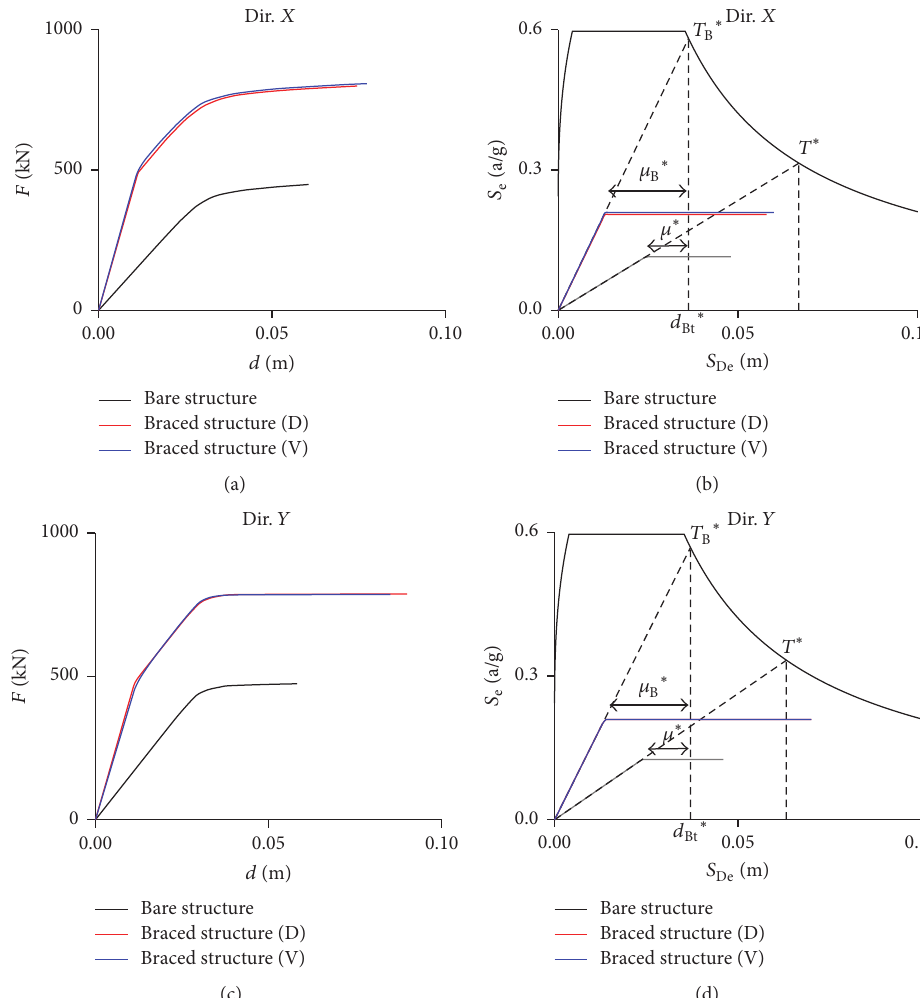
Figure 4: Comparison between pushover curves of the building with and without seismic retrofit: (a) direction 𝑋 and (c) direction 𝑌 ; verification of upgraded structure using NTC08: (b) direction 𝑋 and (d) direction 𝑌 .